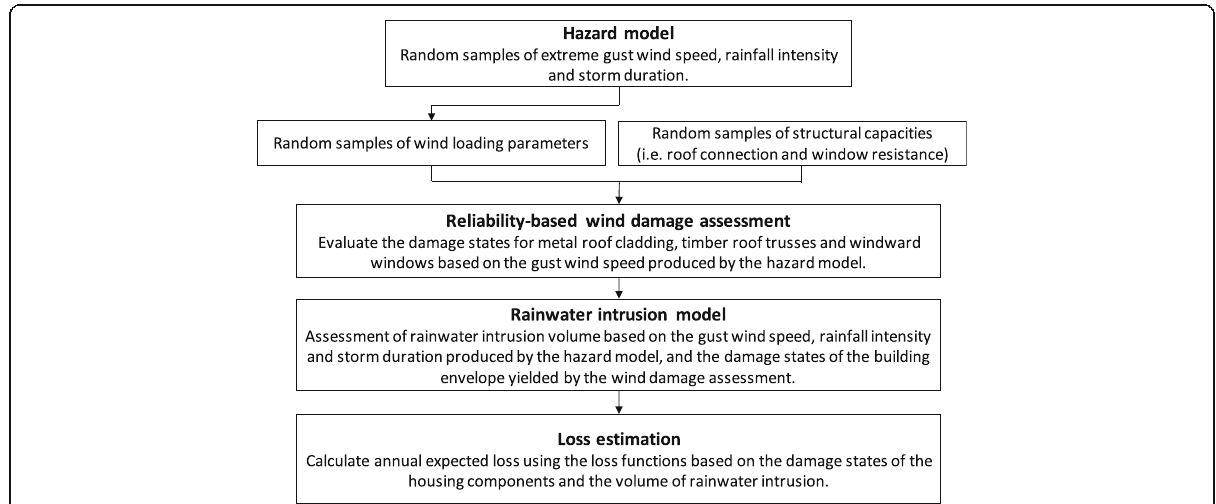
Fig. 8 Outline of the risk analysis method [26]